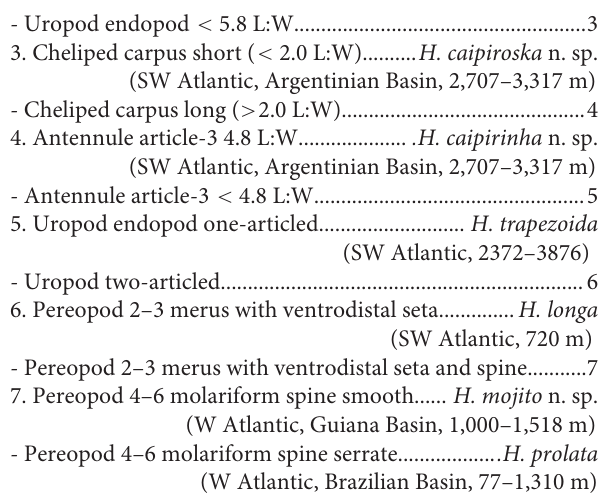
( Figure 11A ) slender, 15.3 L:W. Cephalothorax narrow, 2.4 L:W, 0.8x pereonite-1, naked. Pereonites smooth, wider anteriorly, margins gently rounded. Pereonites 1–6: 2.4, 3.3, 3.3, 2.5, 2.0 and 1.7 L:W, respectively. Pereonite-1, 0.7x pereonite-2; pereonite- 2 same length as pereonite-3; pereonite-3, 1.3x pereonite-4; pereonite-4, 1.2x pereonite-5; pereonite-5, 1.5x pereonite-6. Pleon 0.1x of total body length; pleonites 1–5 same size, 0.3 L:W. Pleotelson 1.4x pereonite-6. Antennule ( Figure 11B ) 0.6x cephalothorax; article-1 2.3 L:W, 0.6 of antennule length, with four penicillate ventral setae, several fine midlength seta on dorsal margin, and simple distal seta; article-2, 1.3 L:W, 0.6x article-3, with two long distal setae; article-3, 4.0 L:W, with distal spur, one penicillate and six long setae distally. Antenna ( Figure 11C ) article-1 fused with the cephalothorax; article-2 1.1 L:W, 1.1x article-3, with dorsodistal long and robust seta (2.0x article-3); article-3, 1.1 L:W, 0.4x article-4, with dorsodistal long and robust setae (0.5x article-4); article-4, 4.0 L:W, 2.0x article-5, with few fine sparsely distributed setae on dorsal margin and four simple distal setae (one longer and three shorter); article-5 4.7 L:W, 7.0x article-6, with distal seta; article-6 minute with distal five setae. Mouthparts. Labrum ( Figure 11D ) rounded and distally setose. Left mandible ( Figure 11E ) incisor distally with two small and blunt processes; lacinia mobilis well developed, distally with five rounded projections; molar process wide, with irregularly undulate margins. Right mandible ( Figure 11F ) incisor distally truncate, with four blunt processes; molar as in left mandible. Maxillule ( Figure 11J ) with at least seven distal spines. Maxilla not seen. Labium ( Figure 11G ) with two lobes, inner lobes finely setose, outer lobe feeble with seta. Maxilliped ( Figure 11I ) palp article-1 1.6 L:W, naked; article- 2 1.6 L:W, with one outer and three serrated inner setae; article-3 1.5 L:W with four inner setae; article-4, slender 2.0 L:W, with five inner and one outer setae. Basis elongated, 2.6 L:W, with distal seta 0.7x endite; each endite distal margin almost simple, with two middle setae, 2 minute gustatory cusps, and lateral corners finely setose. Epignath ( Figure 10H ) distally rounded. Cheliped ( Figure 12A ) basis naked, 1.5 L:W; merus wedge- shaped, with ventral seta; carpus 2.2 L:W, with two ventral setae and two short dorsal setae (dorsodistal rod and subproximal simple); chela narrow, 2.9 L:W, 0.9x carpus; palm 1.3x fixed finger with seta on inner side and seta near dactylus insertion; fixed finger, with two ventral setae (unequal length); cutting edge weakly calcified, with three setae; dactylus proximal seta not seen. Pereopod-1 ( Figure 12B ) relatively slender, overall 13 L:W; coxa with seta; basis 5.4 L:W, with middorsal seta; ischium with ventral seta; merus 2.7 L:W, 0.8x carpus, with distal seta; carpus 2.7 L:W, 0.8x propodus, with three fine distal setae;